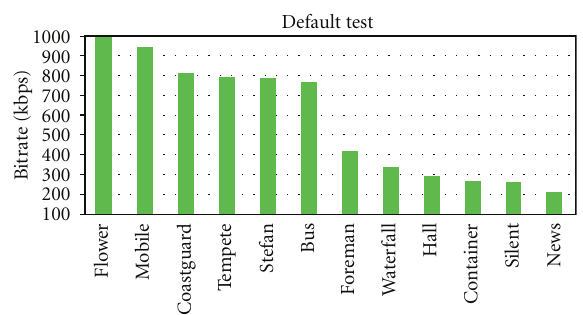
Figure 21: Resulting bitrates under the default setting of x264 for all